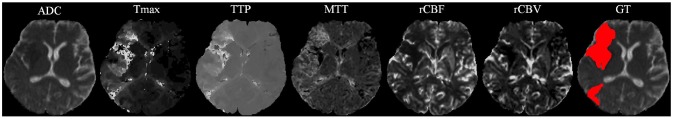
MRI parametric maps of a stroke patient with TICI score 0, and the respective manual segmentation. Only one class is defined, describing simultaneously the infarct core and the penumbra regions.